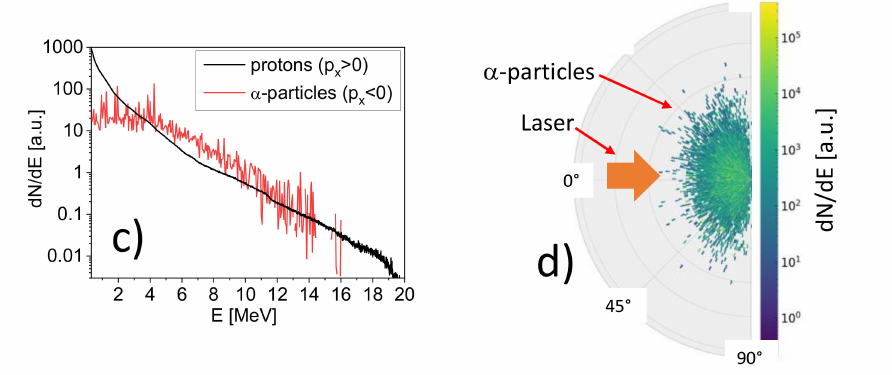
Figure 4. ( a ) The proton density map that was calculated by 2D PIC simulations at t = 2.8 ps (i.e., 1.2 ps after the highest intensity peak entered the highest density part of the target); ( b ) the proton phase space plot at t = 2.1 ps (the proton density is shown in units of plasma critical density); ( c ) the proton energy distribution (p x > 0) and α -particle energy distribution at the target’s front side from PIC and Monte Carlo simulations, respectively; and ( d ) the α -particle angular distribution from the same simulation